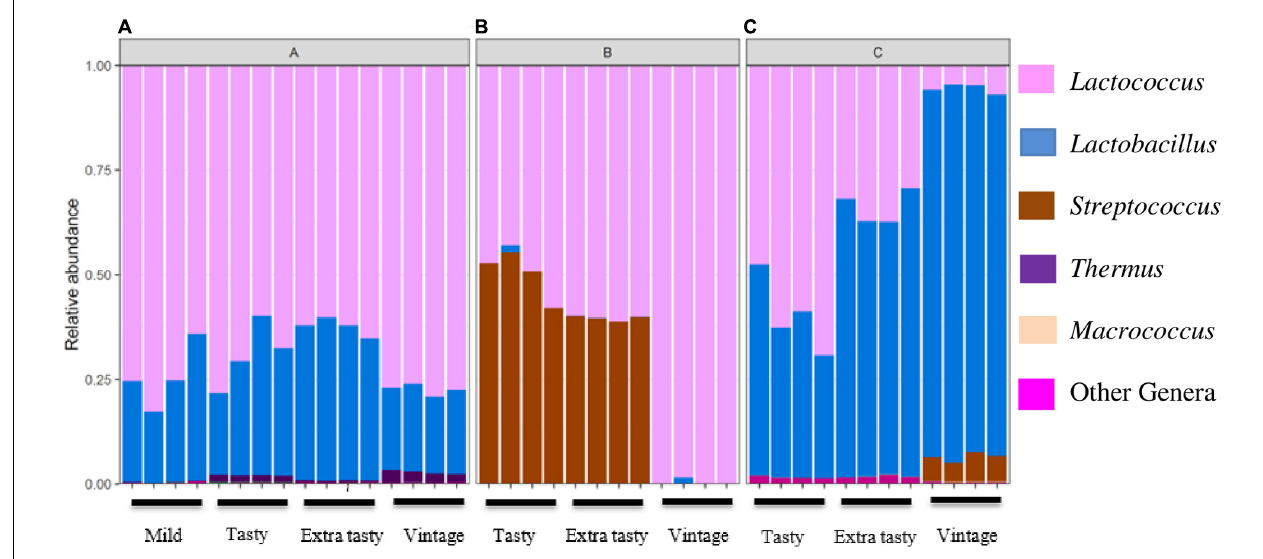
FIGURE 1 | Variation in the relative abundance of bacterial genera in cheeses between brands and between cheeses of different maturity. Brands (A–C) are as indicated. Only genera detected at > 0.1% relative abundance are shown.